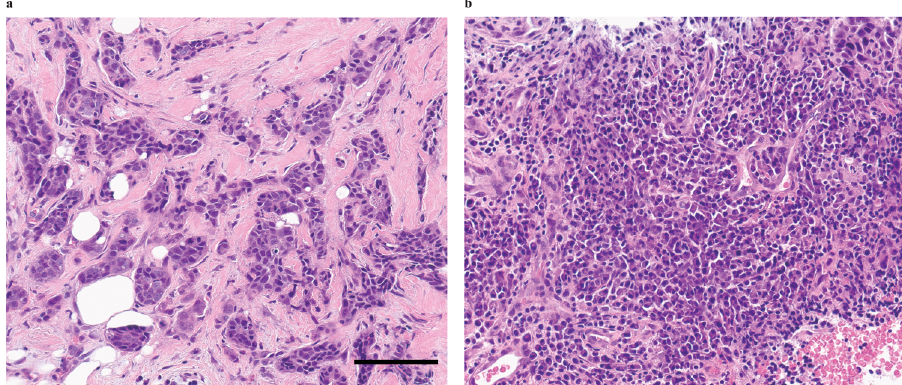
Fig. 3 Representative H&E sections demonstrating TIL percentage in breast cancer specimens. a Low TIL (5%). b high TIL (80%). Scale bar, 100 μ